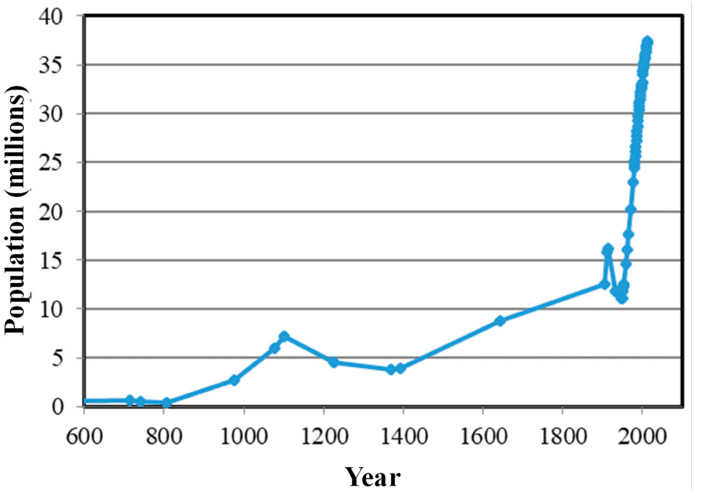
Figure 2. Population of Fujian Province in historical and modern times. Data sources: Xu;